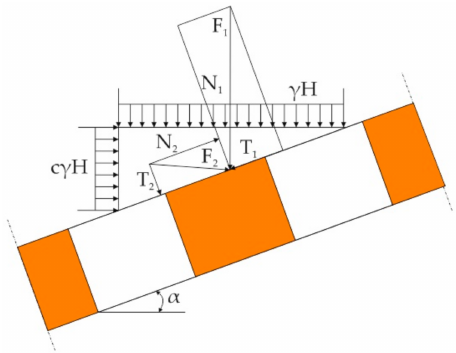
Figure 12. Scheme of loading of cribs in an inclined